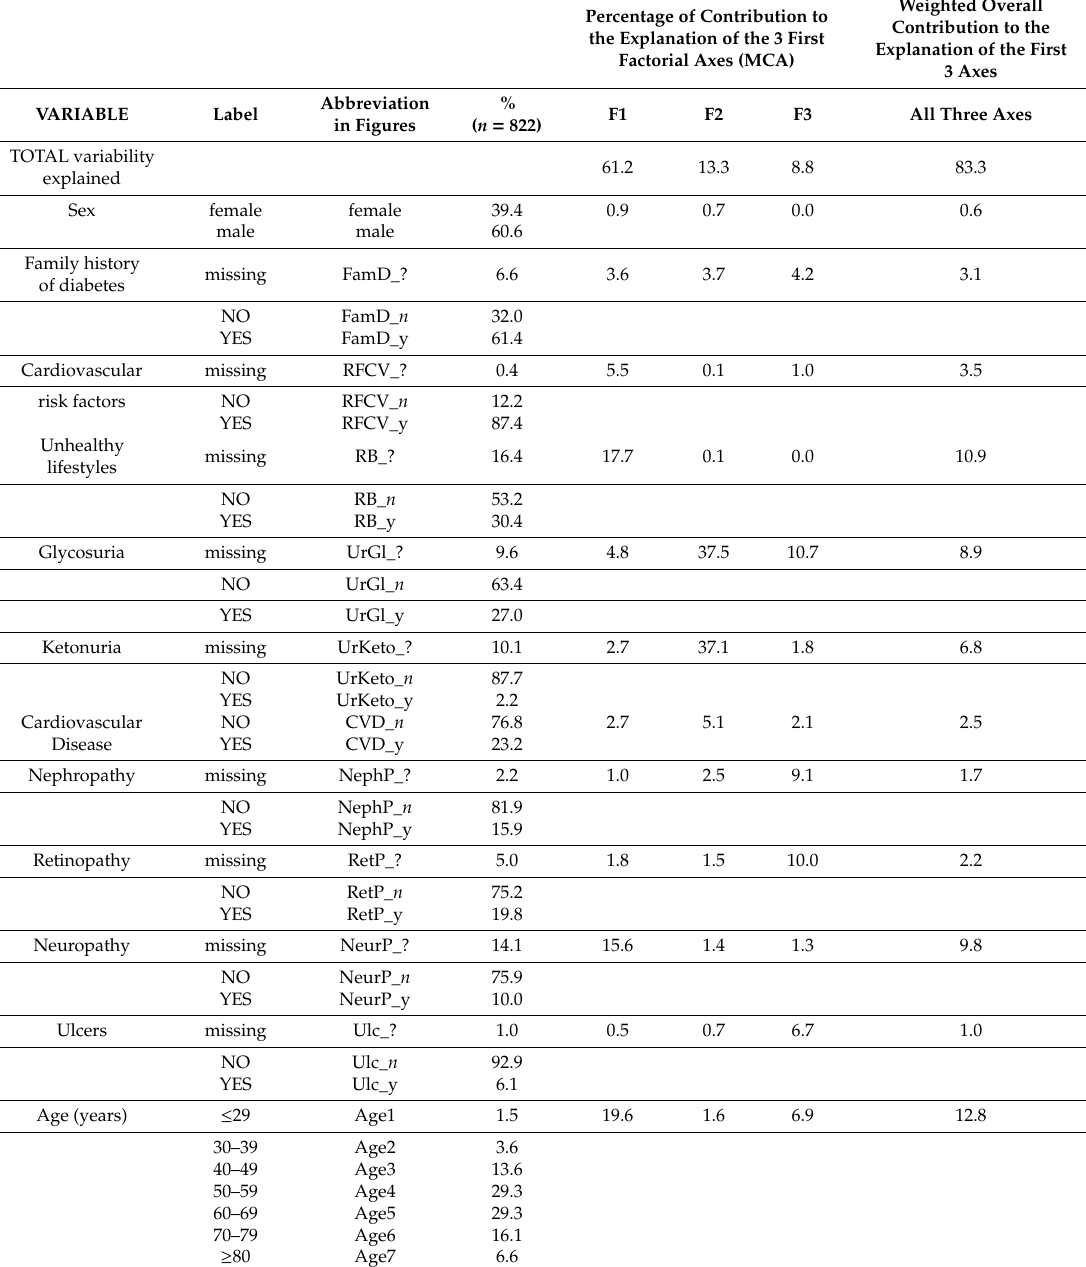
Table 1. Composition of each variable in MCA. Percentages of explanation of the first three factorial axes and legends of abbreviations used in the figures are also given.